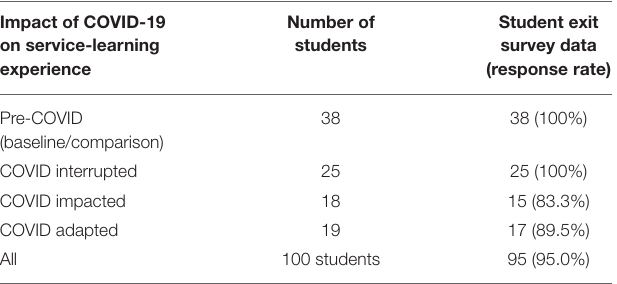
TABLE 1 | Service-learning partner organizations. TABLE 2 | Sample size and response rates of exit survey data, reported by PH 485 student enrollment